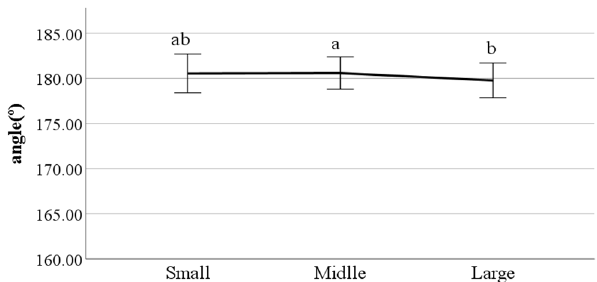
Figure 31. Lateral trunk flexion at the double support phase (left foot forward) (F value: 3.19, DF: 2, p -value: 0.04).